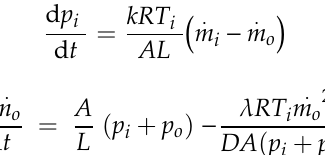
Figure 5. Comparison between experimental [20] and numerical results. 6. The Case Study and Simulation Results 6.1. The Case Study The model has been applied to simulate the loading and the unloading processes of the CNG tanker that is being designed under the GASVESSEL project; see Table 2.